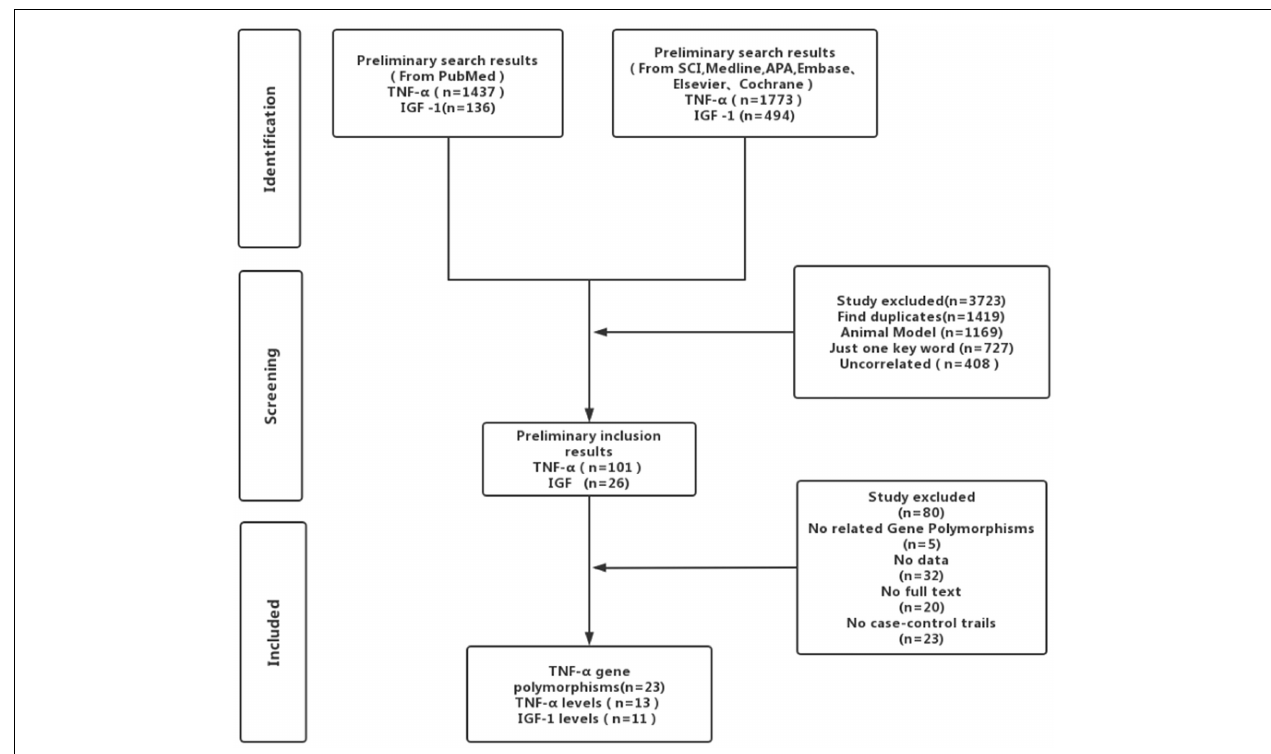
FIGURE 1 | Flowchart of the included